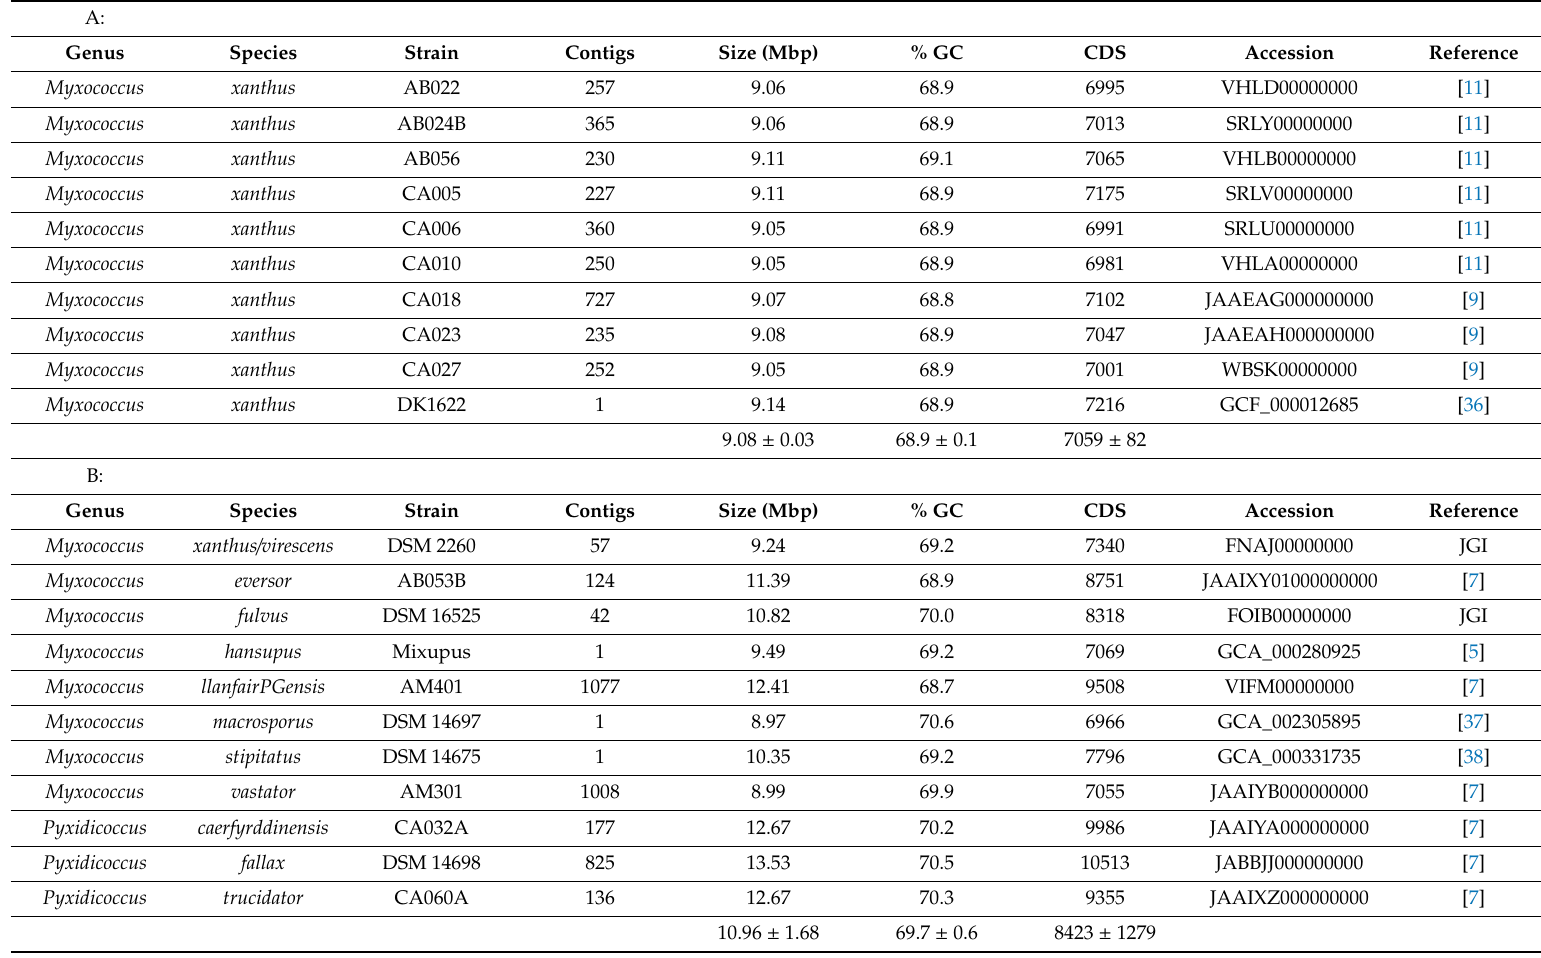
Table 1. Genome properties of selected strains. A: M. xanthus strains, B: Myxococcus spp. type strains, C: Corallococcus spp. type strains, D: C. exiguus strains. In each section, the mean ± standard deviation (and as a percentage of the mean) is provided for the genome size, the % GC, and the number of protein-coding sequences. JGI = Joint Genome